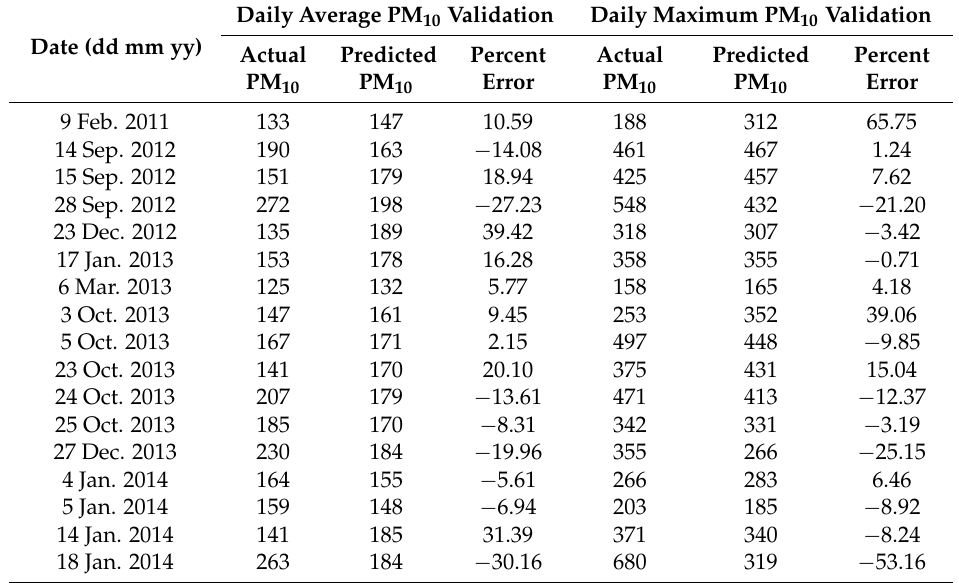
Table 2. Validation of meteorological factors with daily average PM 10 or daily maximum PM 10 .